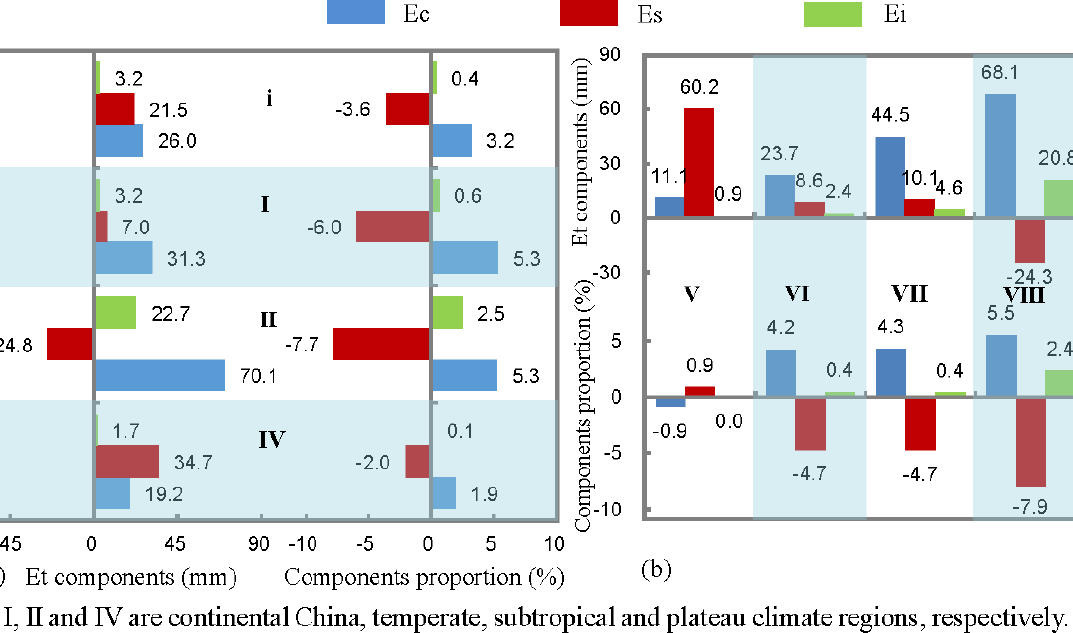
Figure 8. The changes of ET components for grassland ecosystems.